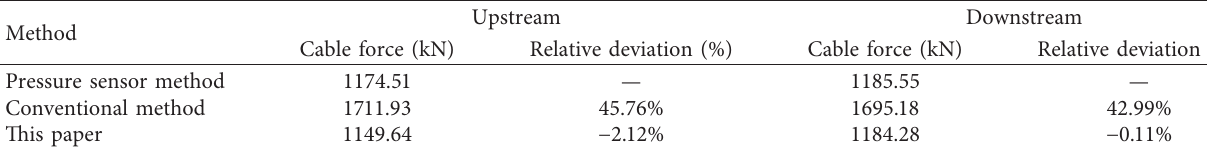
Table 3: Comparison results of cable forces under different test methods.